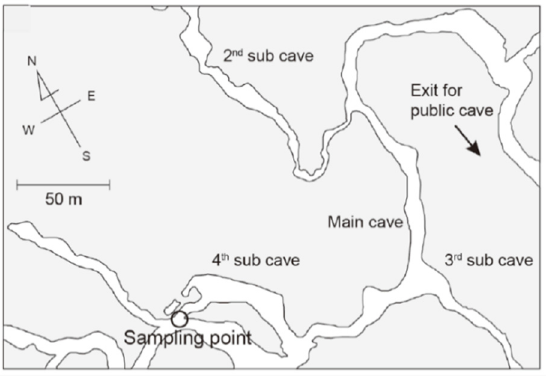
Figure 2. Location of the sampling point in Gyokusendo cave (map from, Shiroma et al. 2016 [20]).